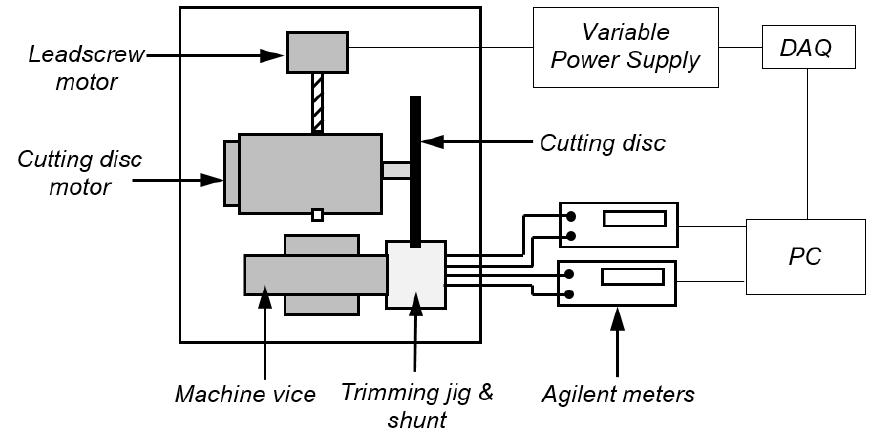
Figure 2. Schematic of the concurrent trimming system.